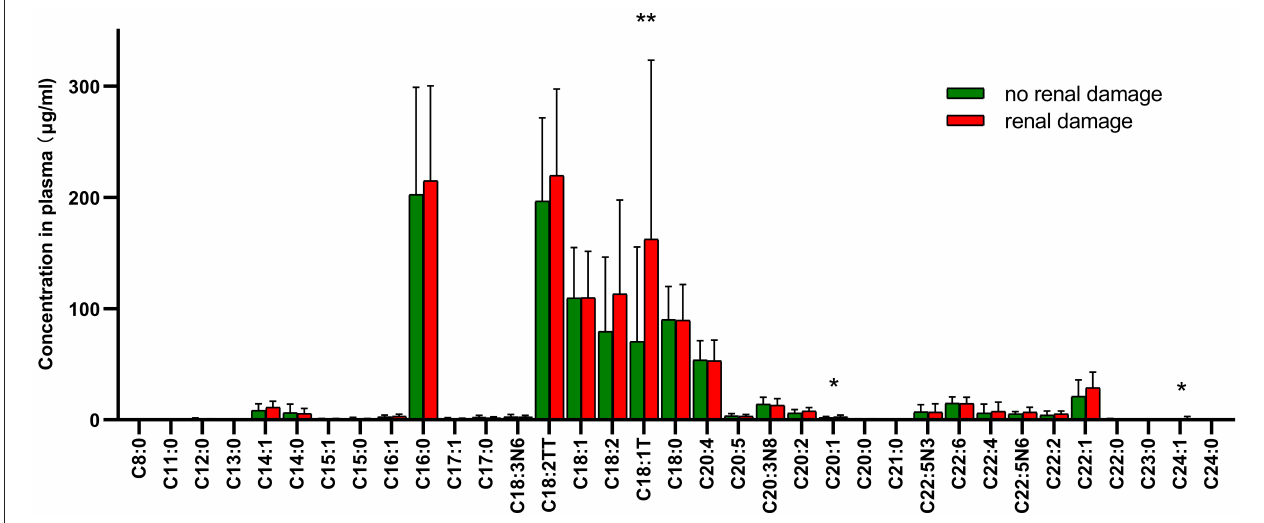
FIGURE 3 | Distributions and correlation in the compositions of fatty acids in two groups with or without renal damage. * means p < 0.05, ** means p <